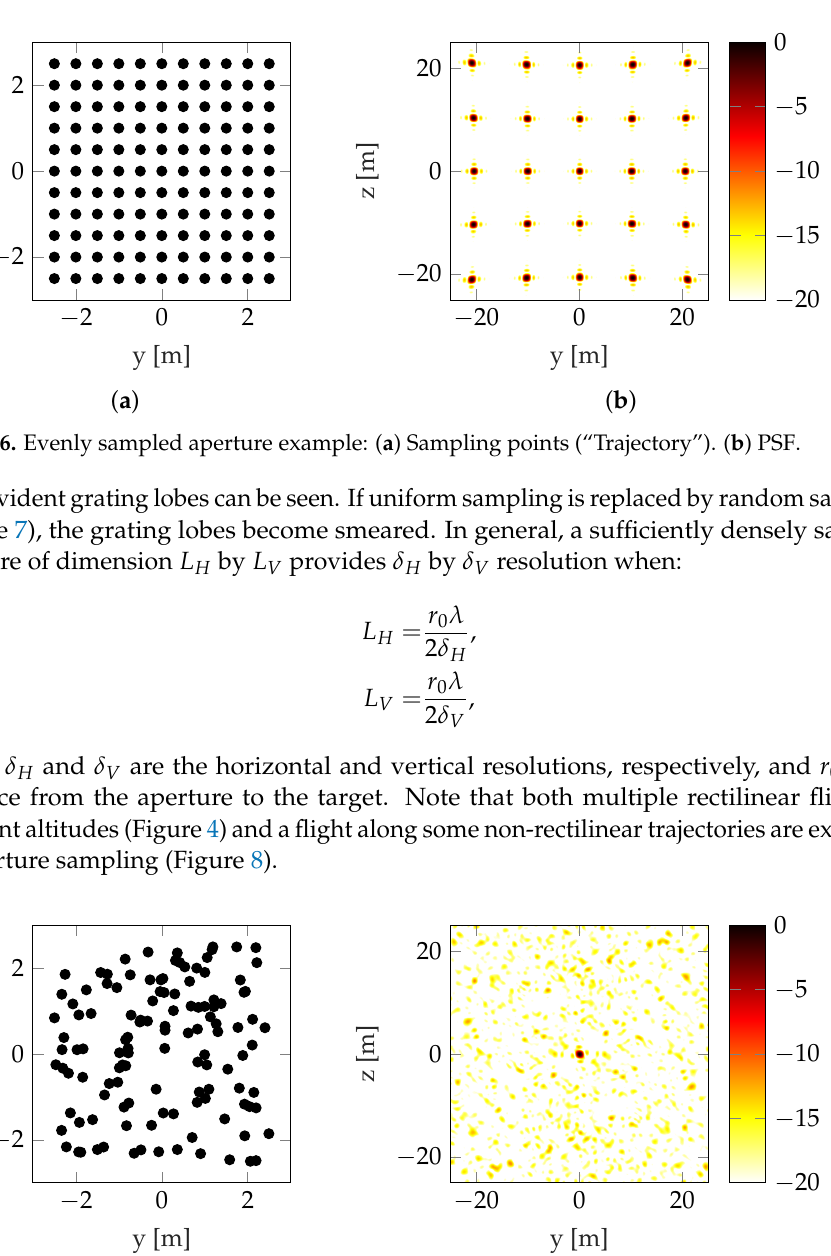
of the surface corresponds to the mainlobe of PSF, while the distribution of sampling points corresponds to the sidelobes (or grating lobes in the case of even sampling). An example is presented in Figure 6.